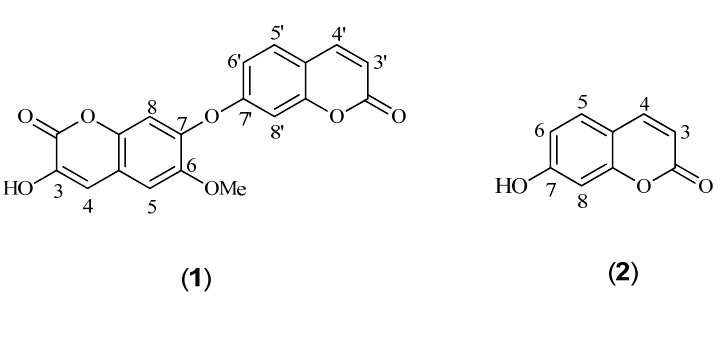
Figure 1. Chemical Structures of 1 – 2 .